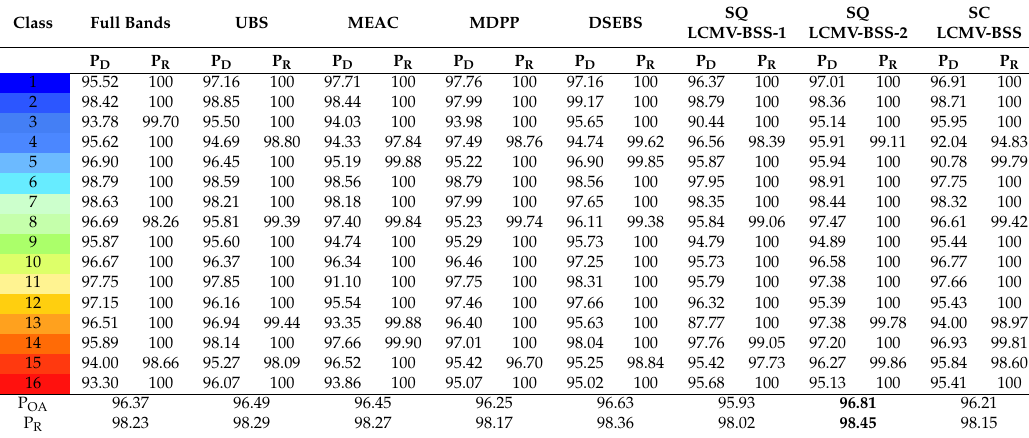
Table 4. P D , P OA , and P R calculated from the classification results in Figure 5 for Salinas.